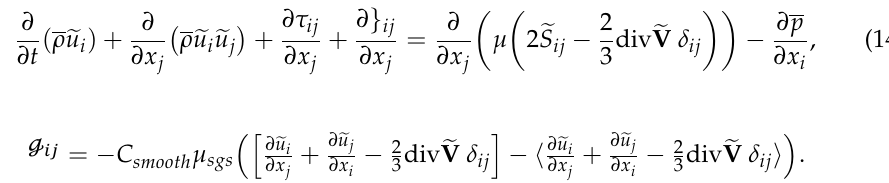
Figure 3. Longitudinal energy spectrum with and without modifications (14) to the DSM.